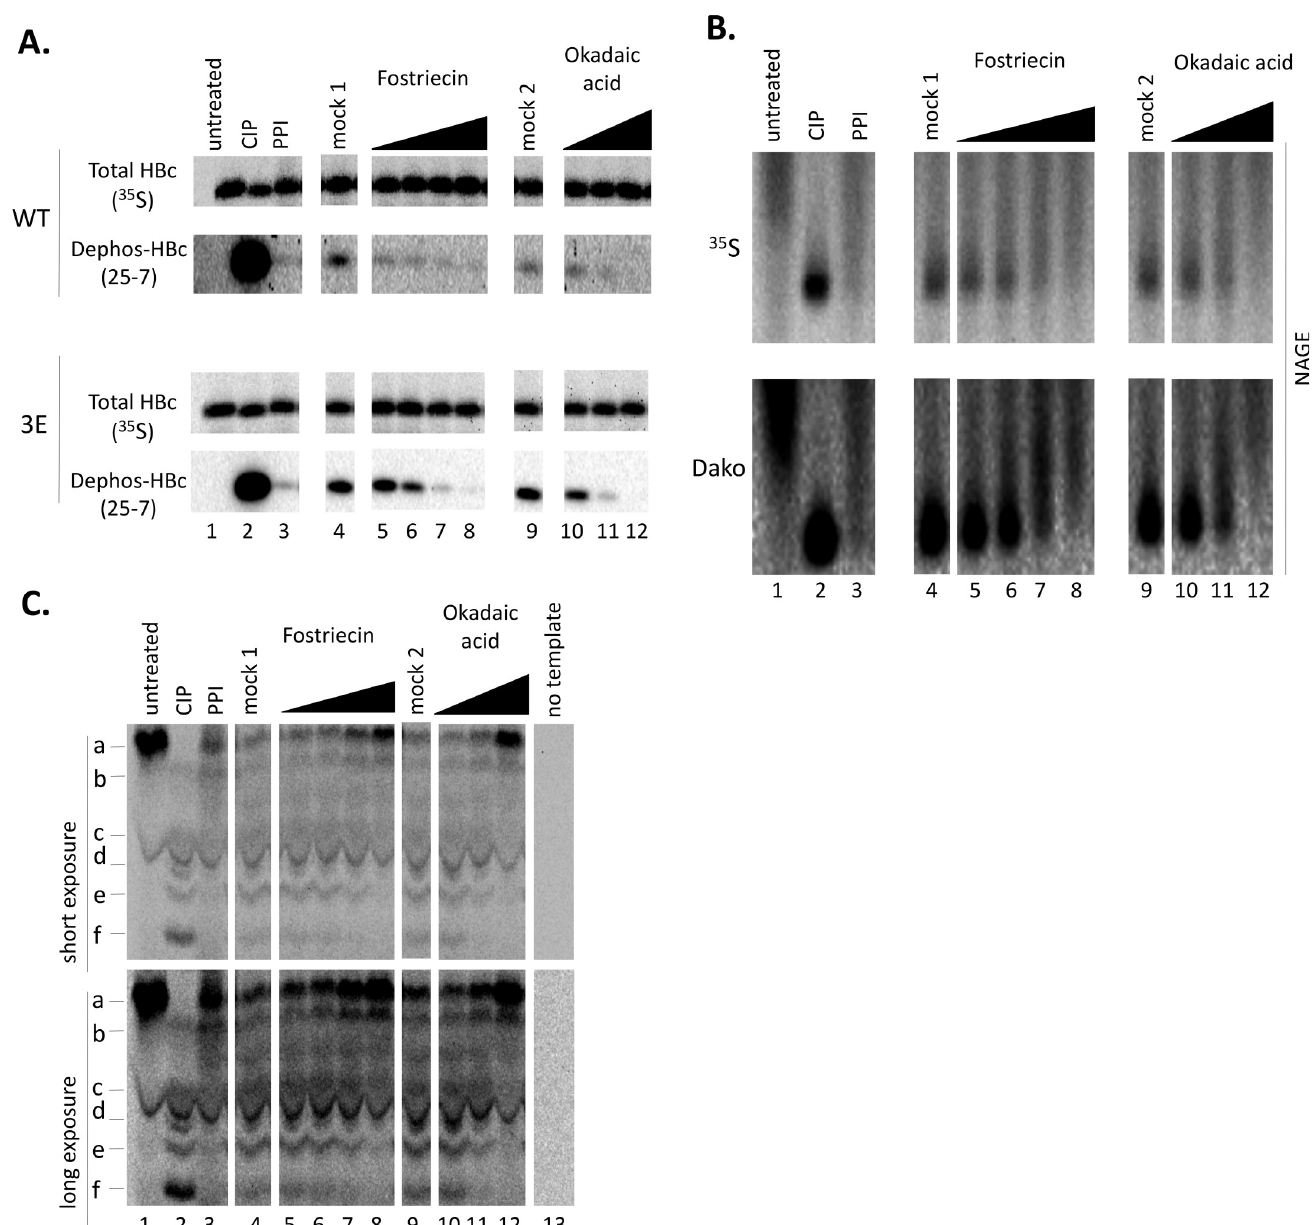
Fig 10. Effects of PP2A inhibitors on HBc dephosphorylation in vitro. The WT and 3E mutant HBc proteins were translated in RRL. The translated HBc, without any further treatment (untreated) or treated with NEBuffer 3 plus CIAP overnight at 37˚C (CIP), with NEBuffer 3 plus a mixture of non-specific phosphatase inhibitors over night at 37˚C (PPI), NEBuffer 3 alone overnight at 37˚C (mock 1), with NEBuffer 3 plus 0.01% DMSO overnight at 37˚C (CIAP) (mock 2), with NEBuffer 3 plus increasing concentrations of Fostriecin (10 nM, 20 nM, 40 nM, 80 nM) or Okadaic acid (1 nM, 10 nM, 100 nM), before further analysis. A. The 35 S-labeled HBc proteins (WT and 3E) were resolved by SDS-PAGE and detected by autoradiography or western blot analysis using the HBc CTD dephosphorylation specific mAb 25–7. B. The HBc 3E reactions were resolved by NAGE. The 35 S-labeled HBc proteins were detected by autoradiography (total HBc) or western blot analysis using the HBc specific polyclonal antibody (Dako). C. The HBc 3E reactions were resolved by Phos-tag SDS-PAGE, with the no- template translation reaction as a negative control, and 35 S-labeled HBc proteins were detected by autoradiography. a & b: hyperphosphorylated 3E; c-e: hypophosphorylated 3E; f: non-phosphorylated 3E.